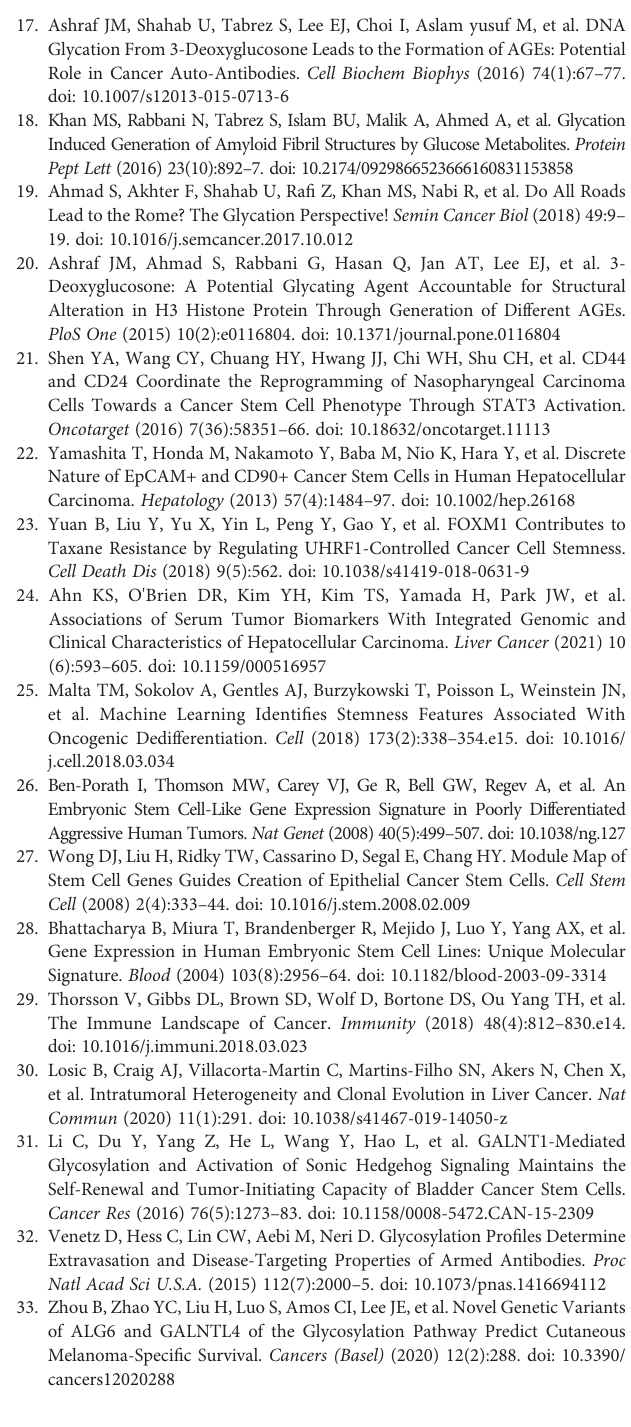
Supplementary Figure 4 | The immune landscape of HCC tumors in ICGC-LIRI- JP. (A) Spearman ’ s correlation of Th2/Th17 in fi ltration, M0/M1 macrophage